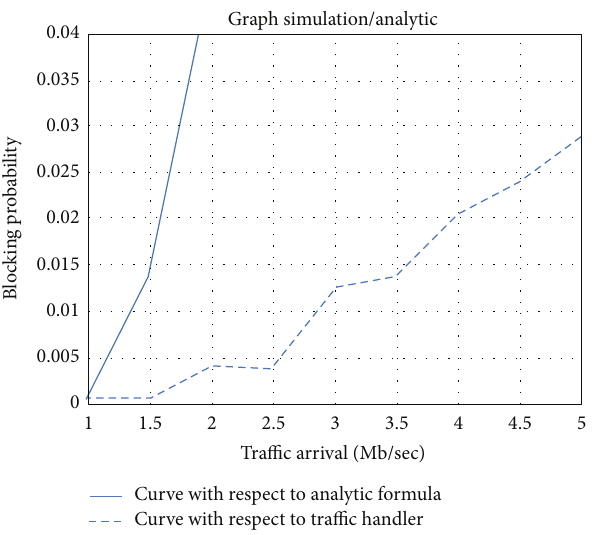
Figure 9: Comparison of request server from local storage with fourth probability set.